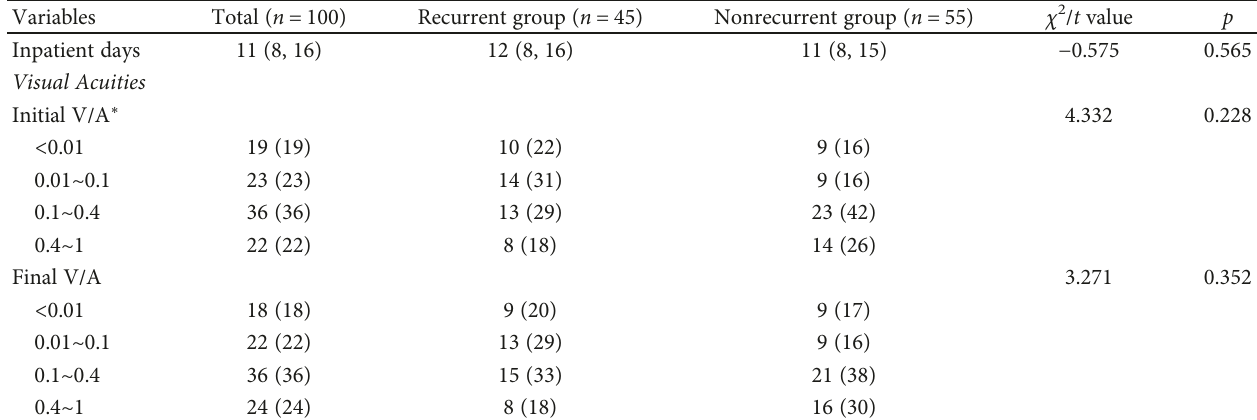
Table 4: Clinical outcomes of a ff ected eyes.